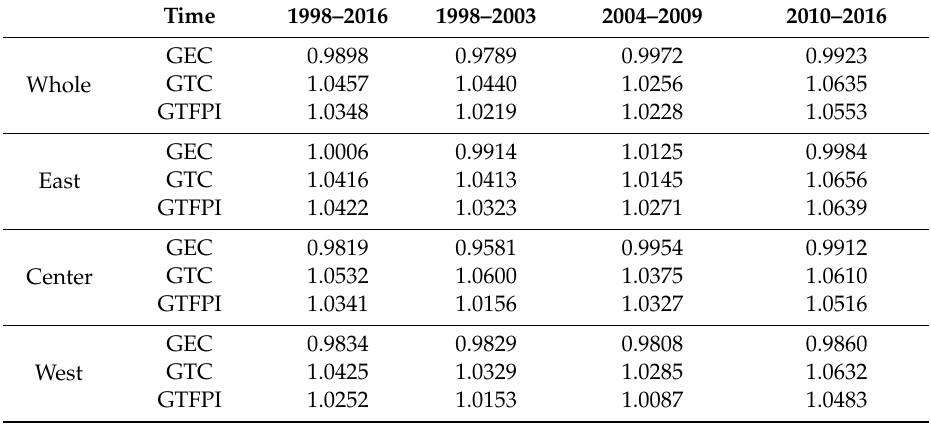
Table 4. China’s agricultural GTFPI, GTEC, and GTPC in di ff erent periods and regions.